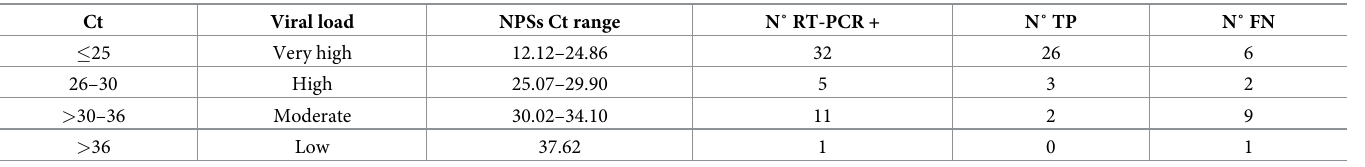
Table 3. RT-PCR positve NPSs according to HSC TWG Ct and AFIAS result.